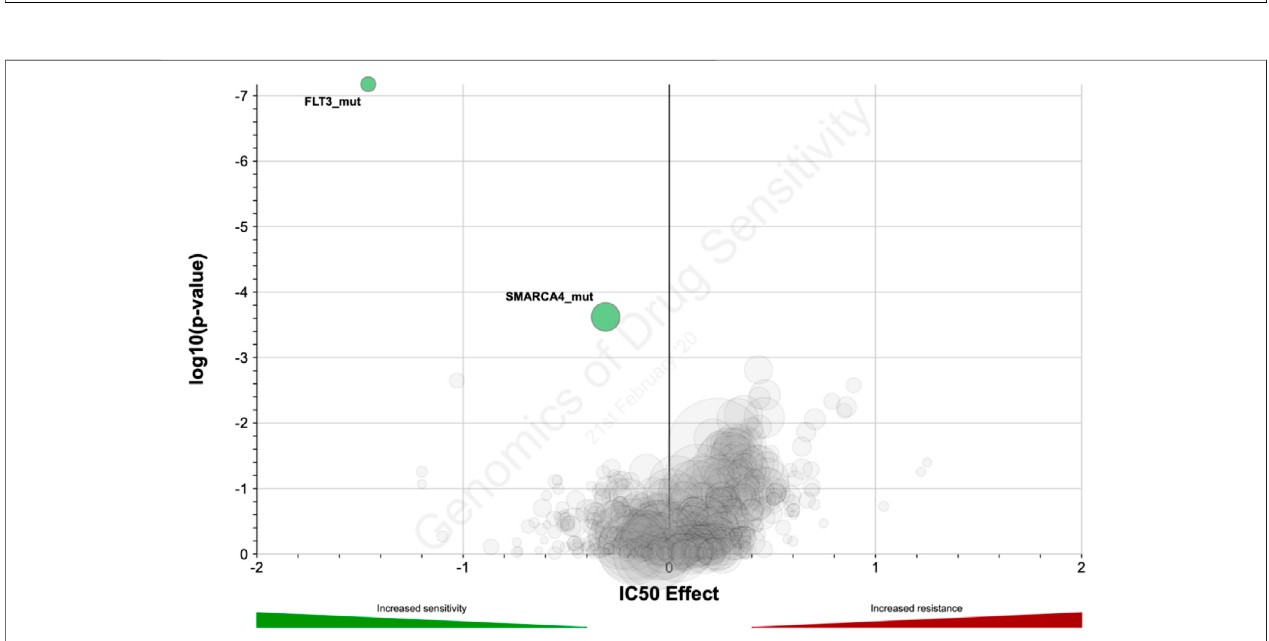
FIGURE7| Distributionoflog10-transformed p -valueandIC 50 differencebetweengroupswithandwithoutgene-speci fi cmutationsandcopynumberalternations in GDSC database.